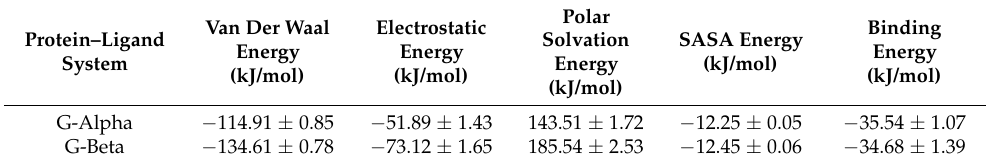
Table 3. The distribution of energy terms contributing to the binding free energy of each protein– ligand (G-alpha and -beta with systems Bipolaroxin). The free energy was computed using MM/PBSA